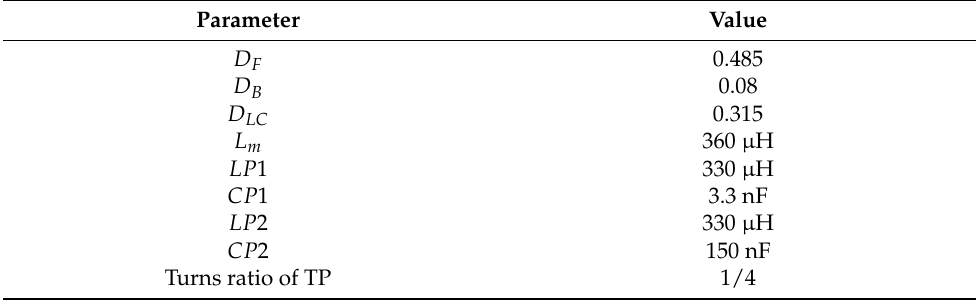
Figure 3. The simulation waveform of i 1 , i LC , i 2_ B , i 2_ R in P2PG&AP mode. Table 3. Parameters of simulation